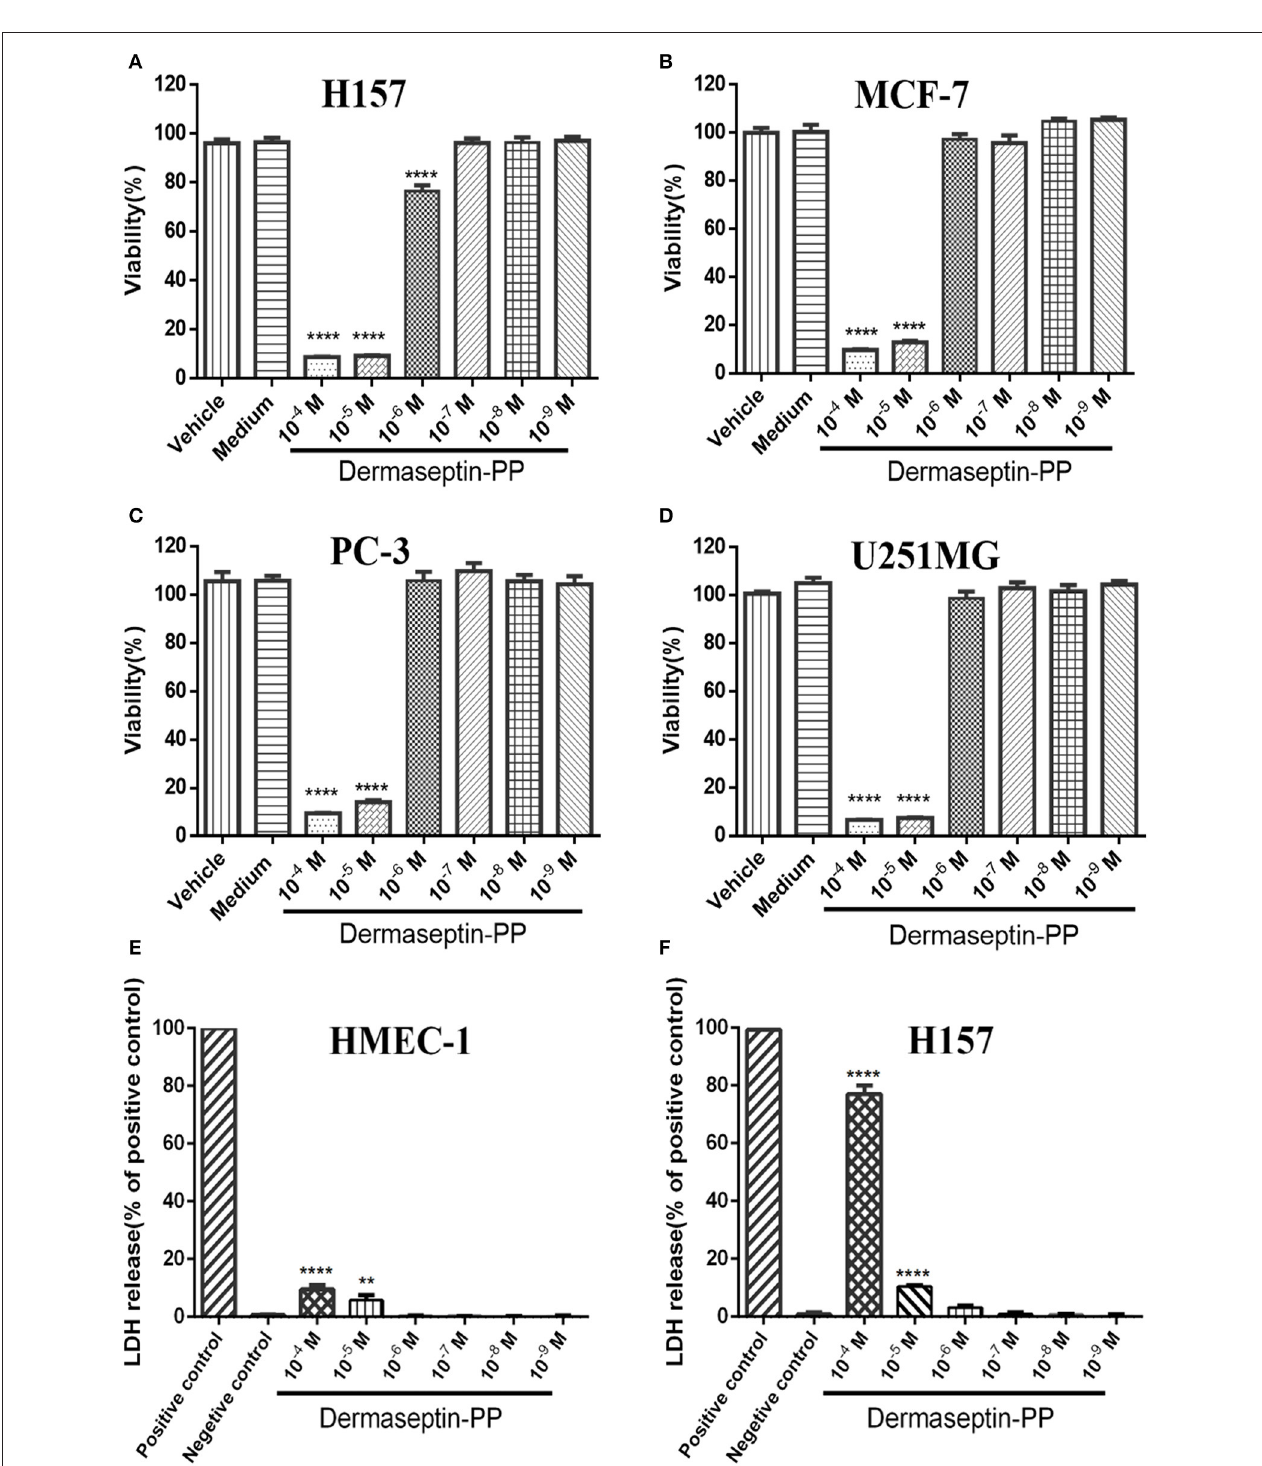
FIGURE 3 | The viabilities of (A) H157; (B) MCF-7; (C) PC-3; (D) U251MG cells treated with Dermaseptin-PP at gradient concentrations from 10 − 4 to 10 − 9 M determined by MTT assays. Vehicle control: cells treated with 1% PBS; Medium control: cells treated with pre-warmed serum-free medium. Values are mean ± SEM of three independent experiments. Data was analyzed with Dunnett’s multiple comparisons of one-way ANOVA using GraphPad Prism. The significance was expressed as p -values: **** P < 0.0001 vs. vehicle control. The percentage of LDH release from (E) HMEC-1 cells and (F) H157 cells treated by Dermaseptin-PP (10 − 4 -10 − 9 M). Values are mean ± SEM of three independent experiments. Data was analyzed with Dunnett’s multiple comparisons of one-way ANOVA using GraphPad Prism. “****” indicates p < 0.0001 and “**” represents p < 0.01 compared with negative control (1% PBS).